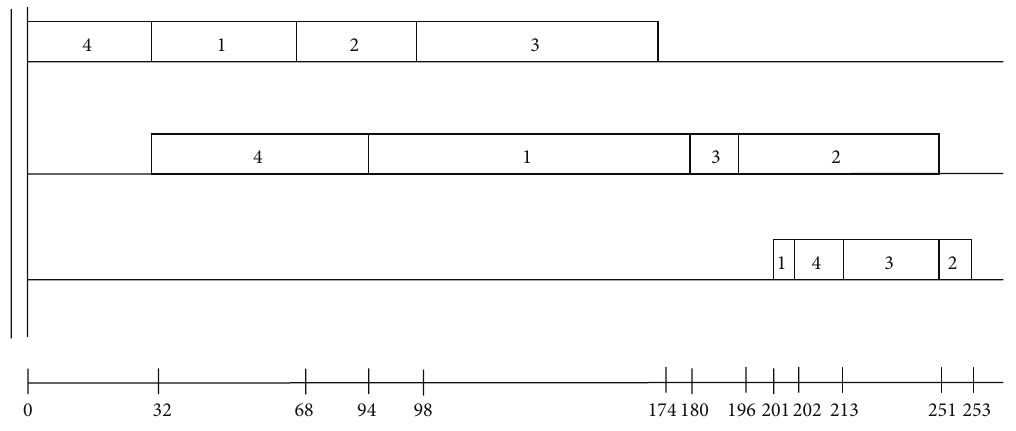
Figure 11: Schedule provided by 𝐻2 for Example